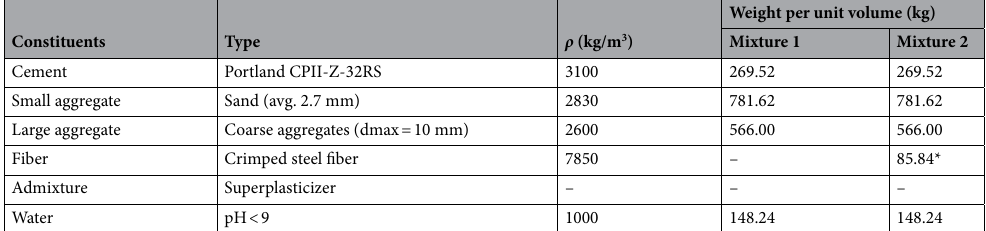
Table 1. Composition of concrete. w/c = 0.55 for all mixtures and slump test workability 140 mm; * V